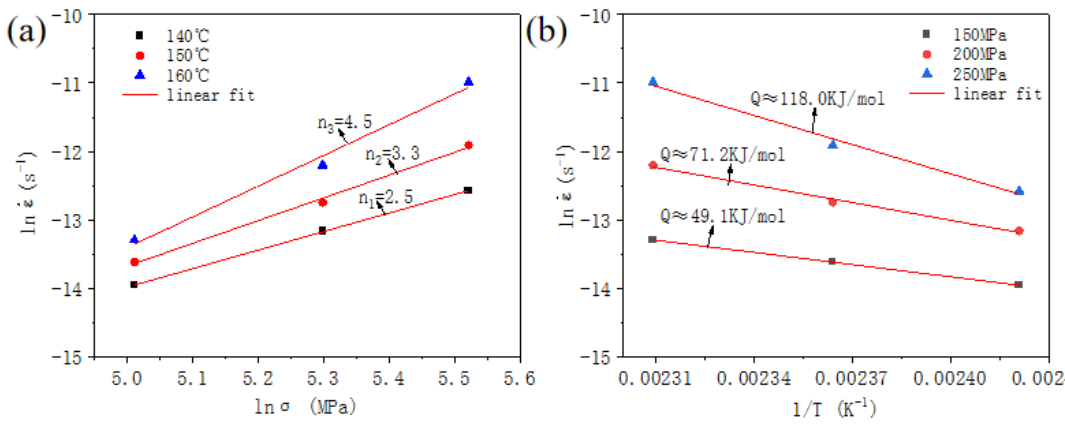
Figure 3. Creep stress exponent ( a ) and apparent activation energy ( b ) of 7B04-P al alloy.